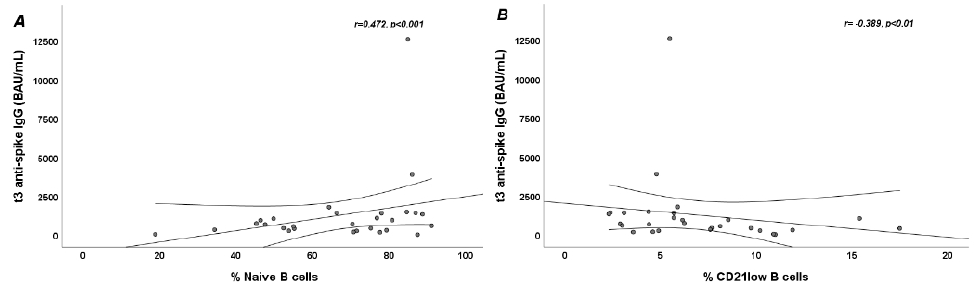
Figure 3. Scatter plots showing linear correlation between B-cell subpopulations and t3 anti-spike IgG serum levels in systemic sclerosis (SSc) patients. ( A ): Positive linear correlation between percentage of naive B cells and t3 anti-spike IgG serum levels ( p < 0.001); ( B ): Negative linear correlation between percentage of CD21 low B cells and t3 anti-spike IgG serum levels ( p < 0.01).